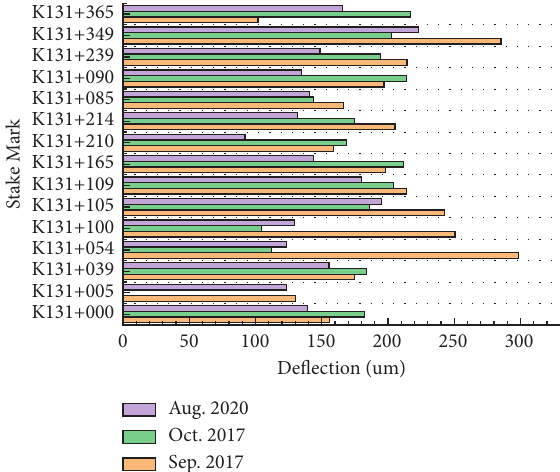
Figure 18: Comparison of average deflections measured in three tests with a 7T load.